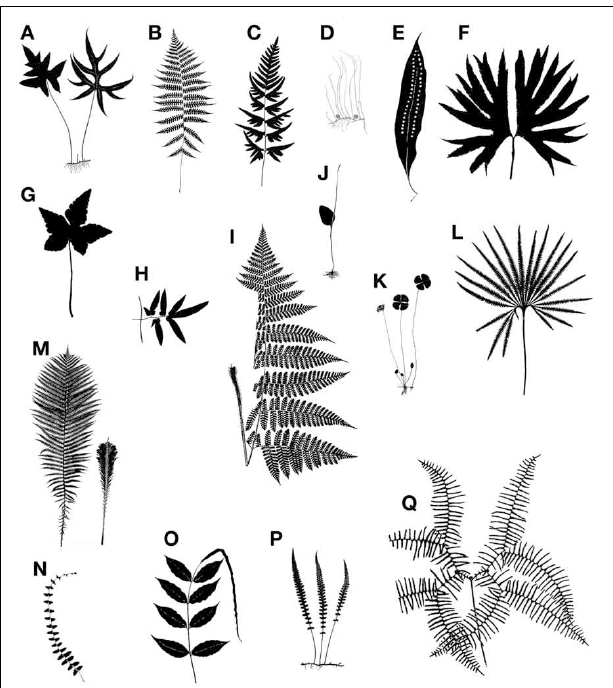
FIGURE 3 | Examples of the diversity of size and shape in fern leaves. (A) Pteris aspercaulis , enlarged basal pinnules on basiscopic side of basal pinnae. (B) Adiantum lunatum , 1-pinnate. (C) Adiantum pedatum, pedate. (D) Adiantopsis radiata , digitate pinnae. (E) Pyrrosia polydactyla, palmately lobed. (F) Actiniopteris semiflabellata , incised leaf. (G) Trachypteris pinnata , holodimorphic, with rosette of sterile leaves and erect fertile ones. (H) Salvinia molesta, root-like (lower) leaf is submerged and bears sori, the two round ones are floating. (I) Pteris ensiformis, holodimorphic, fertile leaf at left. (J) Lemmaphyllum microphyllum , holodimorphic, longer leaf is fertile. (K) Davallia heterophylla, holodimorphic, fertile leaf at left. (L) Olfersia cervina, holodimorphic, fertile leaf at right. (M) Belvisia mucronata, hemidimorphic, with caudate fertile apex. (N) Anemia adiantifolia, hemidimorphic, with two basal pinnae fertile and long-stalked. (O) Osmunda regalis, hemidimorphic, with fertile pinnae at apex. (P) Pellaea cordifolia, decompound. (Q) Gymnocarpium robertianum, ternate. (R) Adiantum raddianum, decompound. (S) Astrolepis sinuata, 1-pinnate-pinnatifid. (T) Polystichum tripteron, enlarged basal pinnae. (U) Hemionitis ariifolia , hastate at left, deltate at right (from same plant). (V) Vittaria lineata, linear leaves (shoe-string fern). (W) Cystopteris bulbifera, long-attenuate apex. (X) Drynaria quercifolia, debris-collecting leaf at right. (Y) Aglaomorpha meyeniana , hemidimorphic, with narrow distal pinnae fertile and base expanded for collecting fallen organic debris. (Z) Cyrtomium macrophyllum, 1-pinnate. (ZZ) Elaphoglossum crinitum, simple,